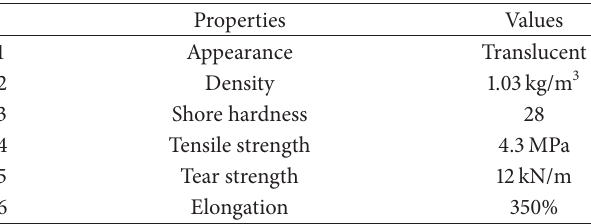
Table 1: Material properties of silicone rubber.